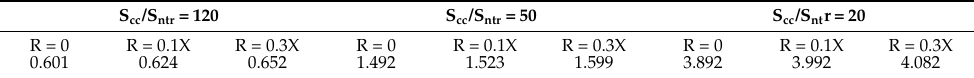
Table 1. Voltage fluctuations for different values of resistance in the electric arc supply